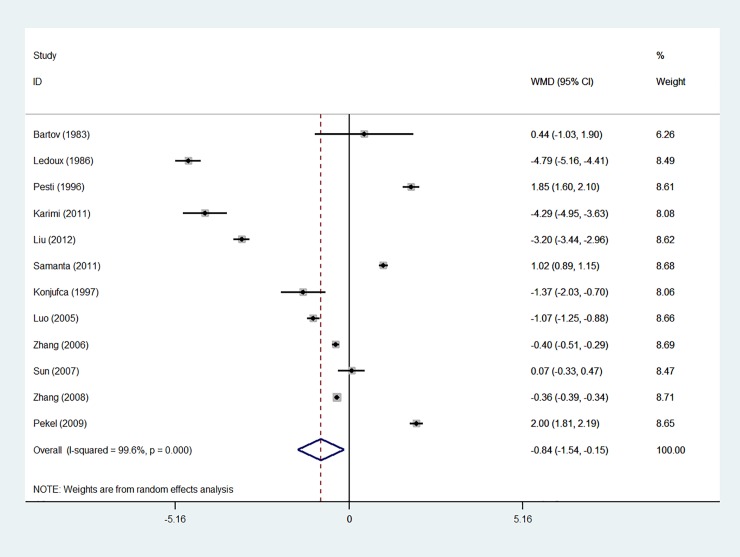
Forest plot of ADFI.